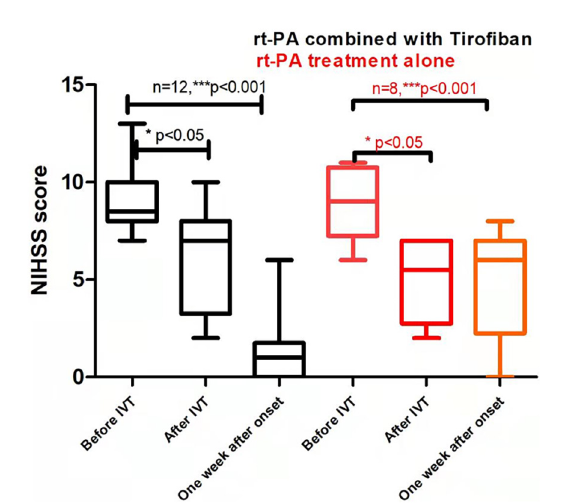
FIGURE2 Comparison of clinical prognosis between recombinant tissue plasminogen activator (rt-PA) treatment alone/control group and rt-PA combined with tirofiban treatment/experimental groups. Values are reported as M (P 25 –P 75 ). P value in the last column indicates the probability of obtaining test results after comparing rt-PA combined with tirofiban group vs. rt-PA treatment group alone. Asterisk indicates significant difference by comparing the scores after IVT or 1 week after onset with the scores before IVT of the same group, * P < 0.05; ** P < 0.01; *** P < 0.001. Parenthesized asterisk indicates significant difference by comparing the scores 1 week after onset with the scores after IVT of the same group, * P < 0.05; ** P < 0.01; *** P <